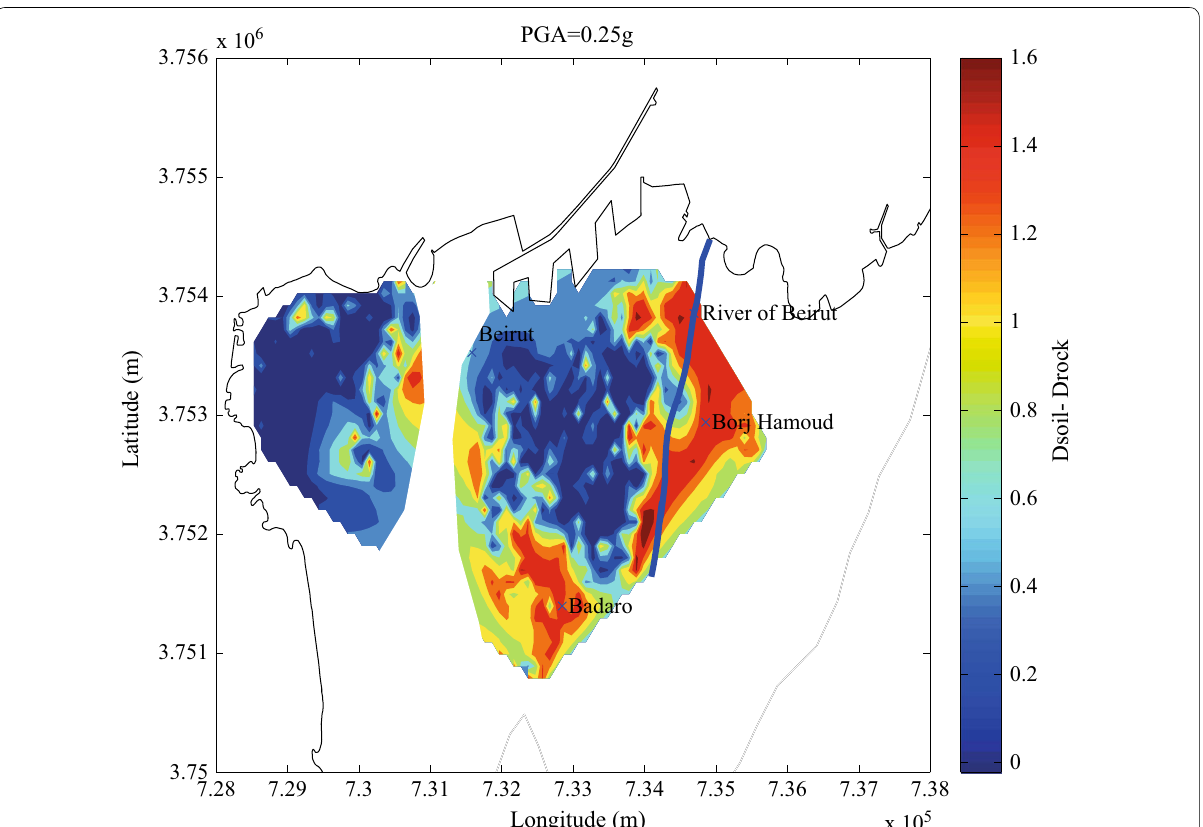
Fig. 10 Interpolated map of the damage increment computed for 7692 buildings in Beirut with the neural network approach (model no. 2) for a rock PGA of 0.25 g, using a 100‑m resolution. Mapping uses the Universal Transverse Mercator (UTM) coordinate system (Zone: 36). The blue line cor‑ responds to the River of Beirut. The color code explained on the right corresponds to the damage increment. Only areas with data for both the soil and the building stock are considered ( white zones correspond to areas with missing information—mainly building